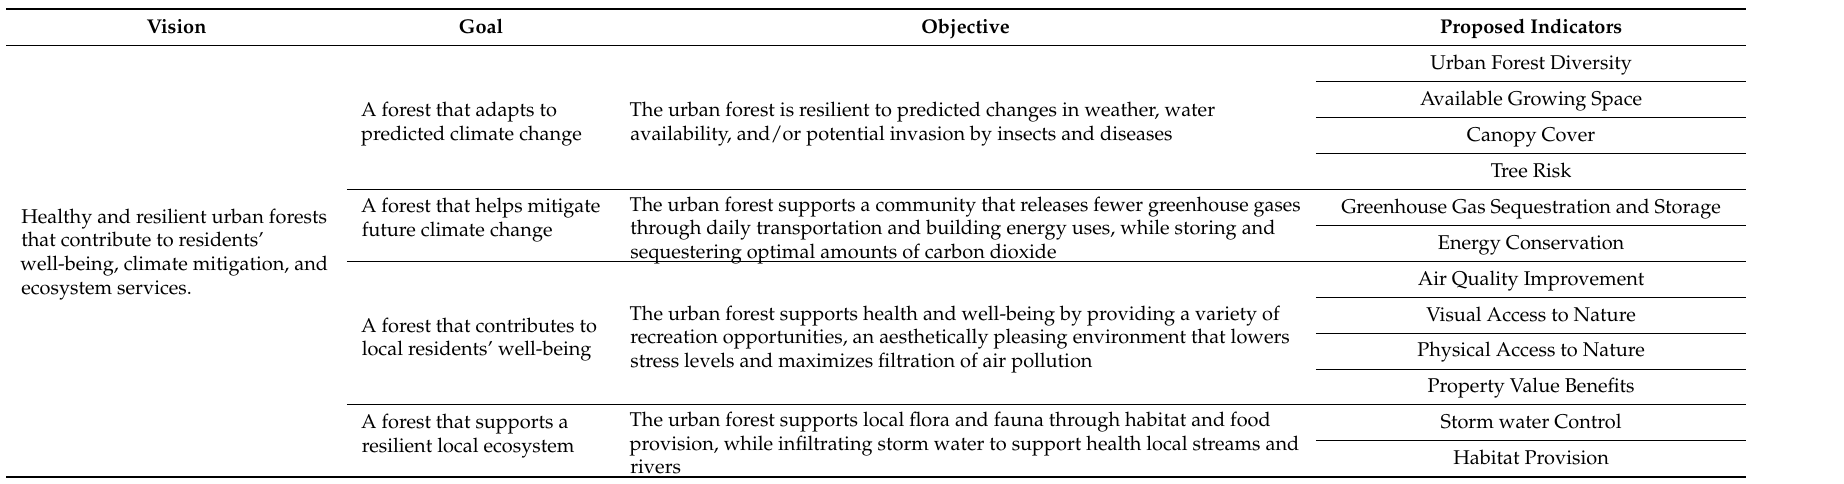
Table A2. Decision Support